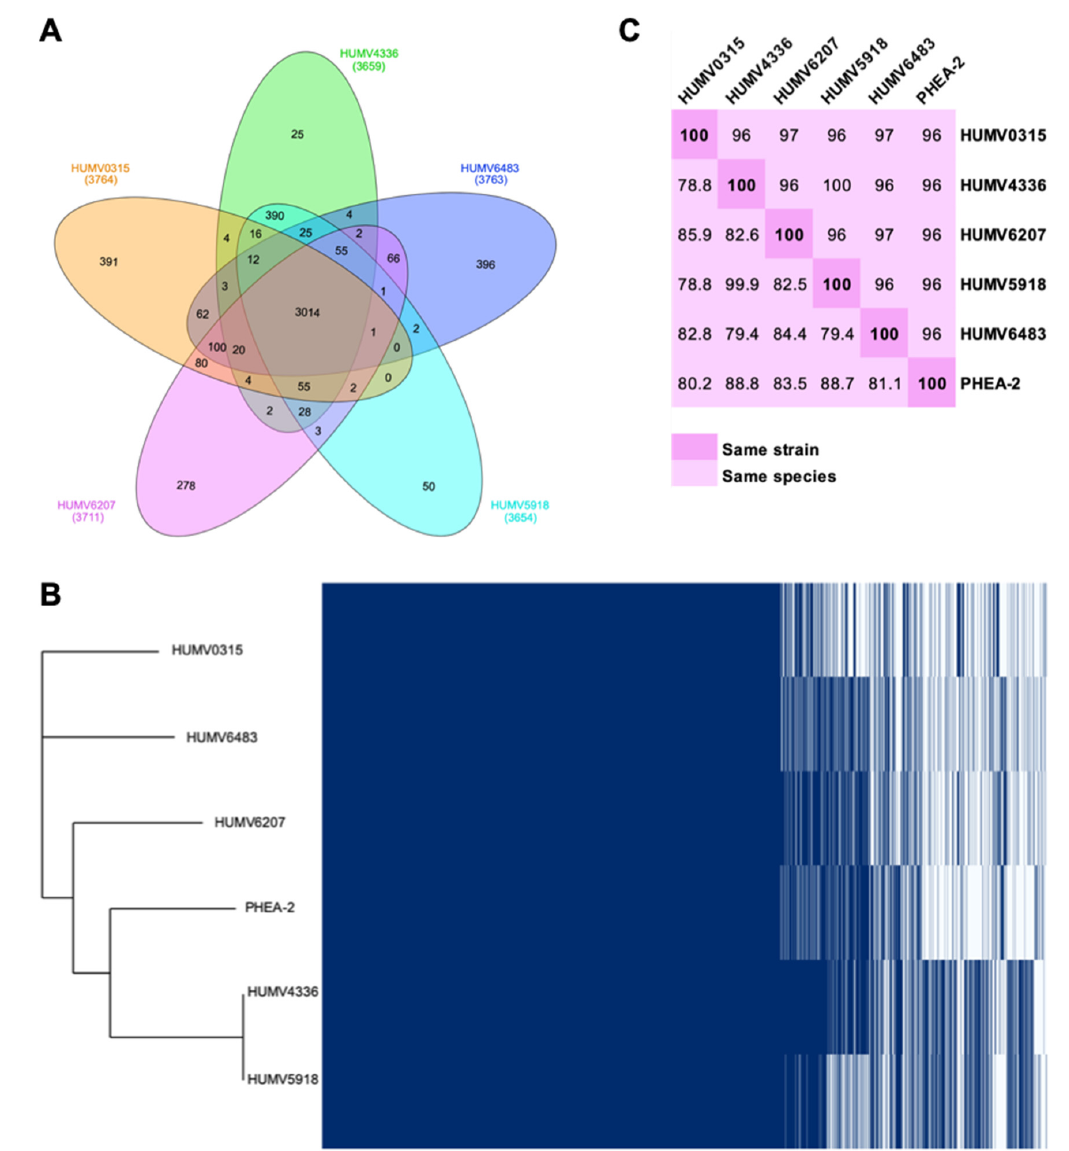
Figure 1. Pan-genome and taxonomic relationship of A. pittii isolates. ( A ) Venn diagram with the pan-genome composition of five A. pittii clinical isolates; in the middle, core-genome size. ( B ) Matrix of presence/absence genes generated with Roary software and the phylogenetic tree of 5 clinical isolates and a reference strain. ( C ) Matrix of evolutive distances in A. pittii strains. The upper part of the matrix shows ANI values; the lowest part of the matrix shows DDH values. ANI >95% and DDH >70% describe the same species; diagonal 100% shows the same